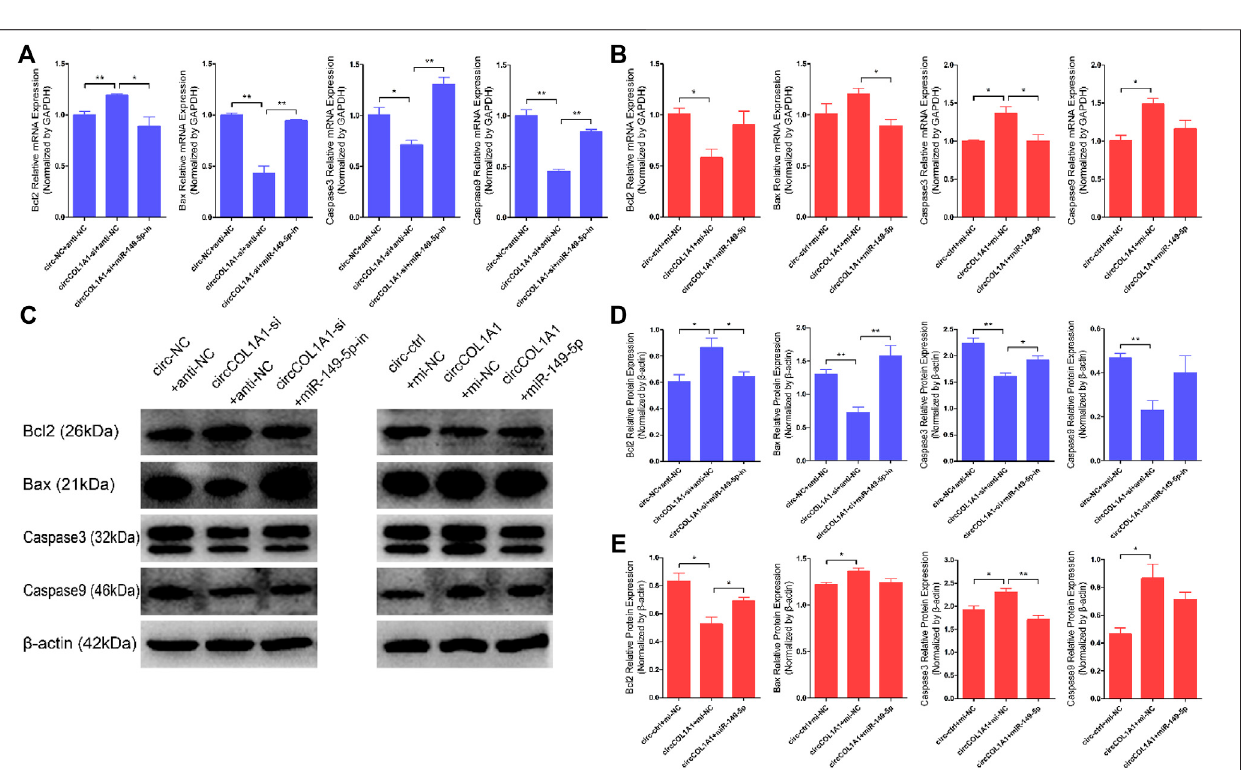
FIGURE 8 | CircCOL1A1 and miR-149-5p cotransfection in fl uenced goat hair follicle stem cell apoptosis. (A) The relative expression of antiapoptotic gene (Bcl2) and proapoptotic genes (Bax, Caspase3 and Caspase9) in hair follicle stem cells co-transfected with circCOL1A1-si and miR-149-5p-in for 48 h. (B) The relative expression ofantiapoptoticgeneandproapoptoticgenesinhairfolliclestemcellsco-transfectedwithcircCOL1A1and miR-149-5p for48 h (C,D) Proteinexpressionof antiapoptotic gene and proapoptotic genes in hair follicle stem cells co-transfected with circCOL1A1-si and miR-149-5p-in for 48 h (C,E) Protein expression of antiapoptotic gene and proapoptotic genes in hair follicle stem cells co-transfected with circCOL1A1 and miR-149-5p for 48 h (F,G) The cell apoptosis rate was detected at 48 h after cotransfection with circCOL1A1-si and miR-149-5p-in by Annexin V-FITC/PI double staining followed by the fl ow cytometry assay. (H,I) The cell apoptosis rate was detected at 48 h after cotransfection with circCOL1A1and miR-149-5p byAnnexin V-FITC/PI double staining followed by the fl ow cytometry assay.